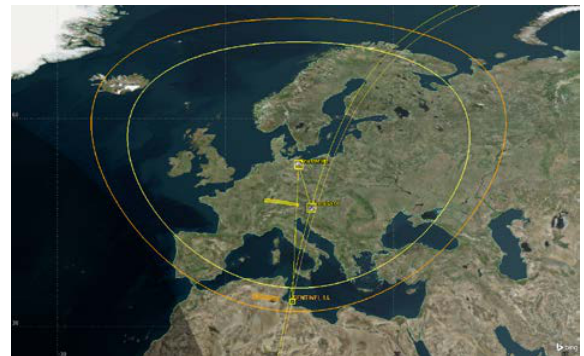
Figure 1. Ground Station Neustrelitz, acquisition circle for Sentinel-1 and TerraSAR-X; 5 degree elevation